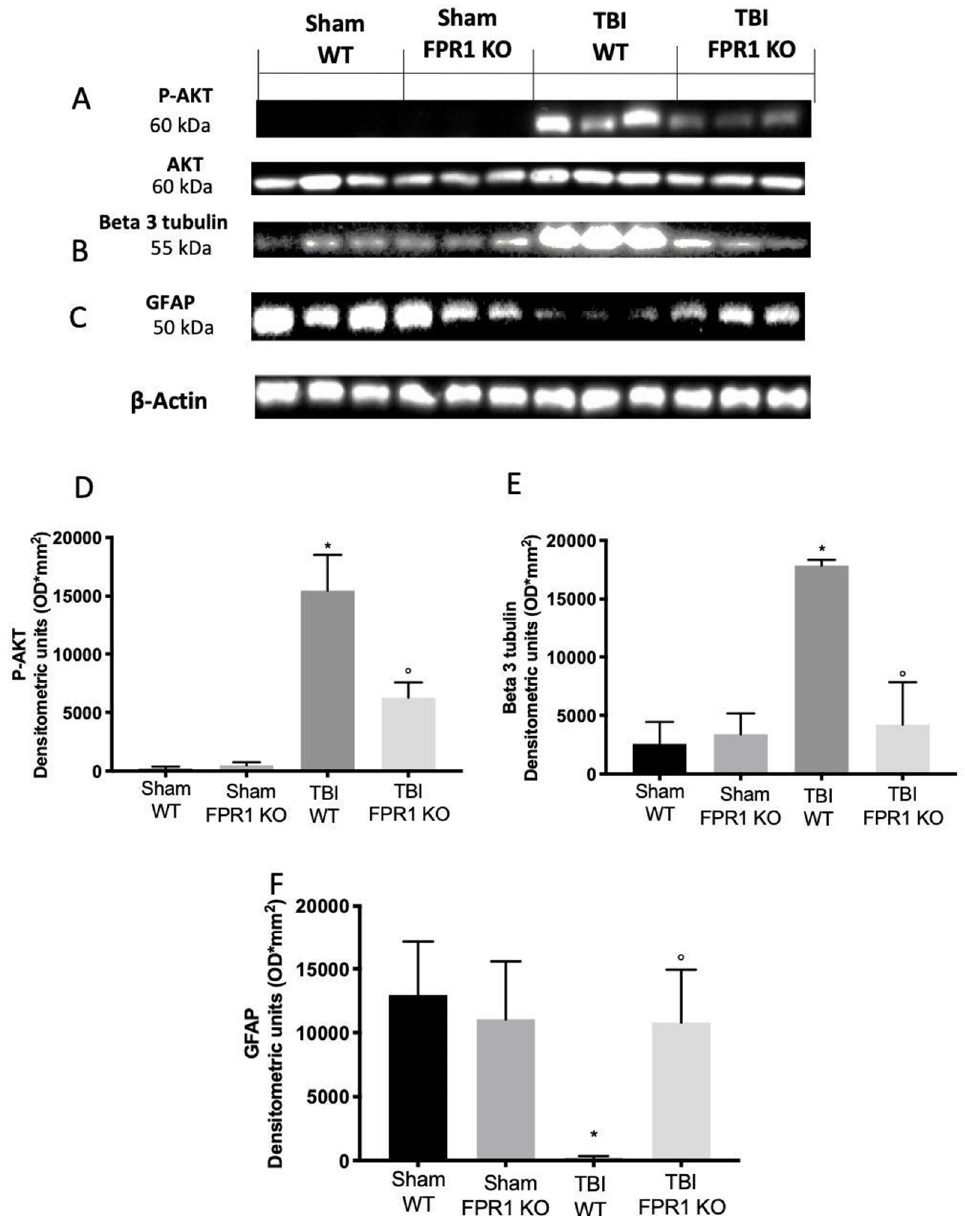
Figure 15. Effect of the absence of Fpr1 on neuronal differentiation: Western blot analysis shows an upregulation of p-AKT ( A ) and β 3-tubulin ( B ) expression in the TBI WT group four weeks after injury, compared to the Sham WT and Sham Fpr1 KO group. Fpr1 KO animals four weeks after TBI show reduced levels of p-AKT and β 3-tubulin compared to the TBI WT group; see the densitometric analysis ( D , E ) The same analysis shows basal expression of GFAP ( C ) in the Sham WT group and Sham Fpr1 KO group. A significant reduction in GFAP expression is expressed in the TBI WT group four weeks after injury, while TBI Fpr1 KO animals show a restored expression of the Glial Fibrillary Acidic Protein expression; see the densitometric analysis ( F ) For the analyses, n = 5 animals from each group were employed. Results were analyzed by two-way ANOVA followed by a Bonferroni post-hoc test for multiple comparisons. Non-parametric data were analyzed with Fisher’s exact test. * p < 0.05 vs. Sham WT; ◦ p < 0.05 vs. TBI WT.